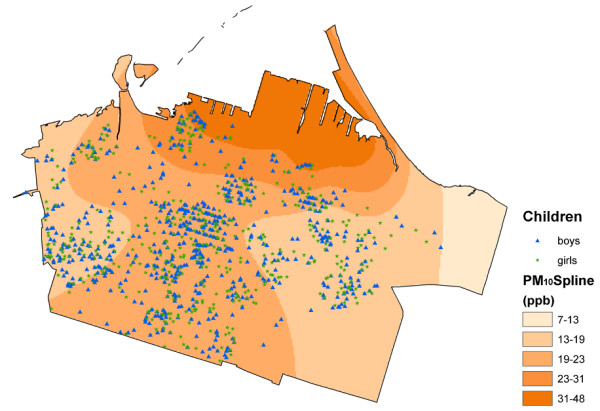
PM10 Spline surface.